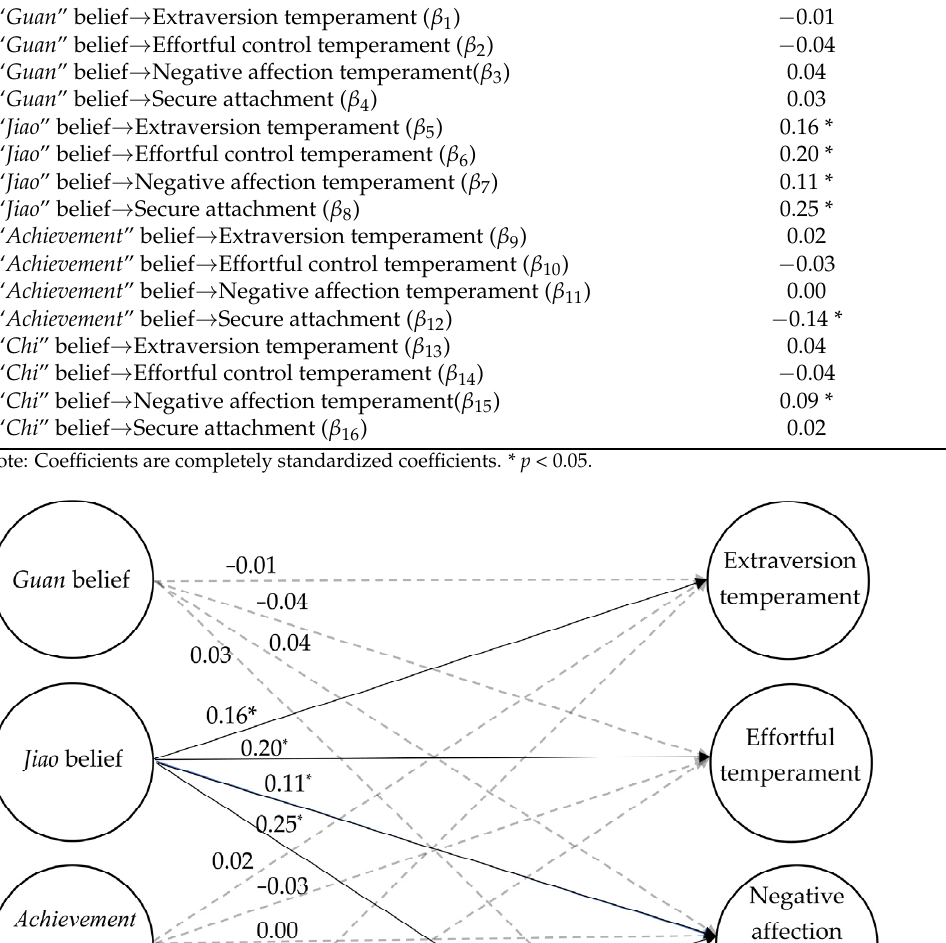
Table 1. The structural coefficients of Chinese parenting beliefs on preschooler’s temperament and secure attachment.